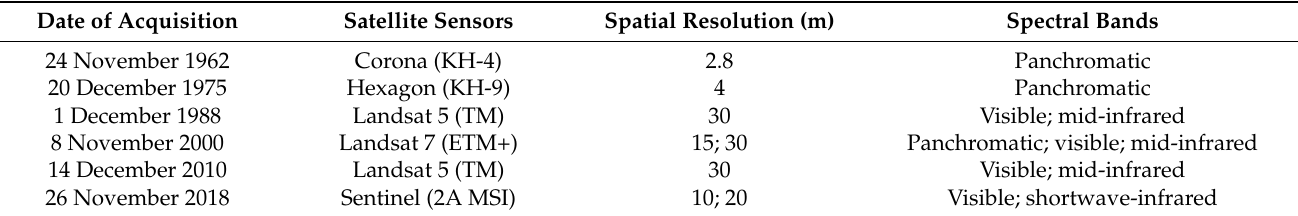
Table 1. Satellite remote-sensing data used in the current